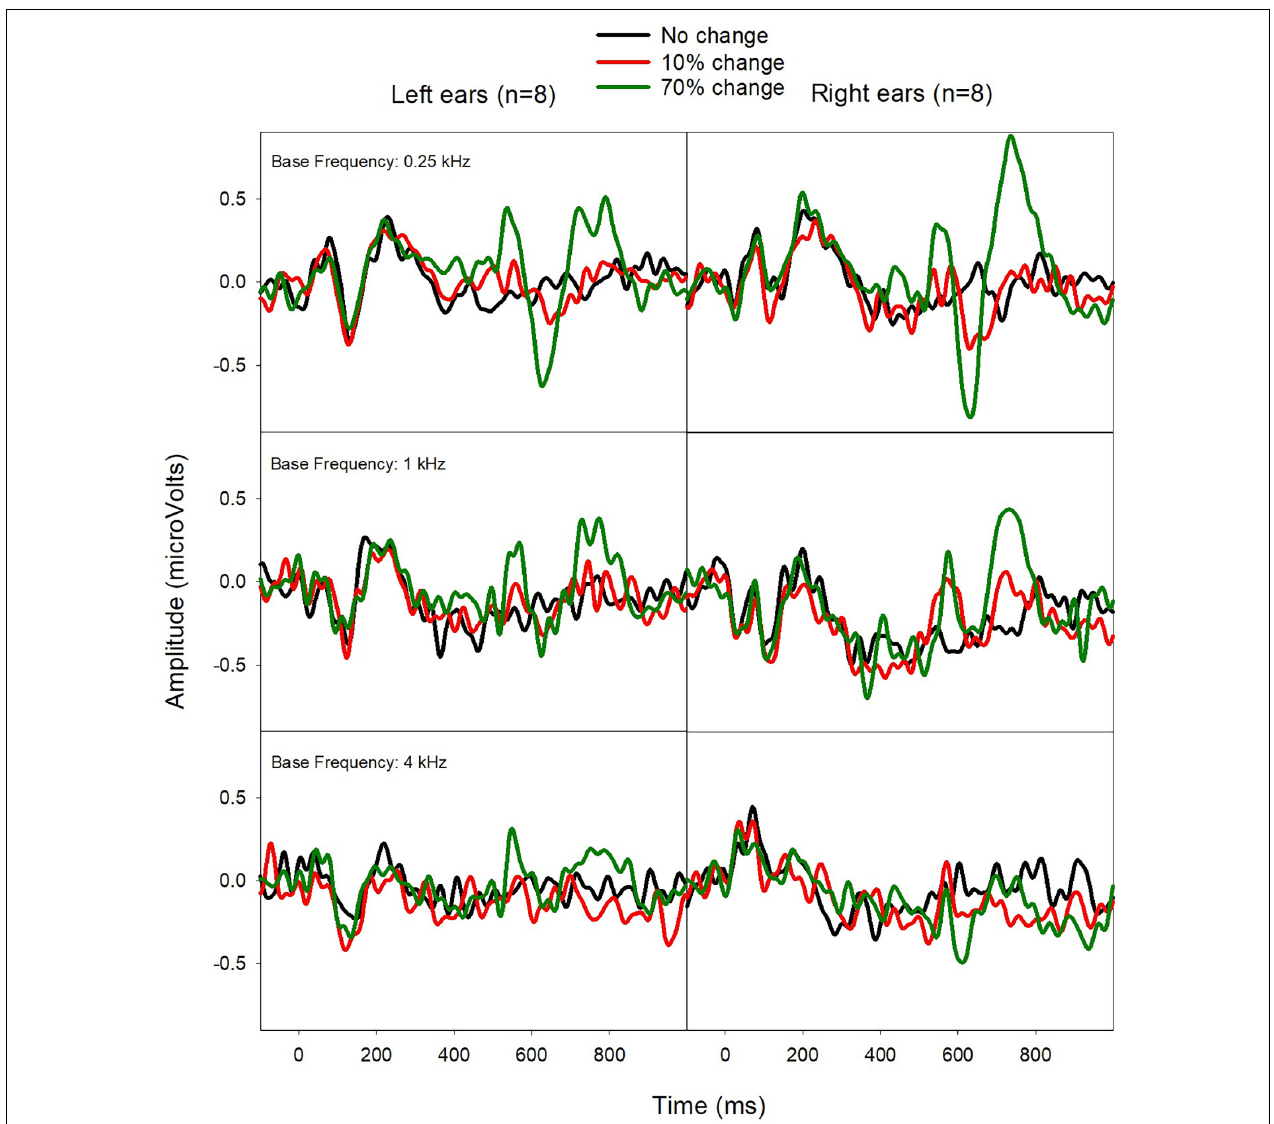
FIGURE 5 | Mean ERPs from Left (left) and Right CI ears (right) in eight bilateral CI users. The ACCs were larger for Right CI ears for the f base at 0.25 kHz.